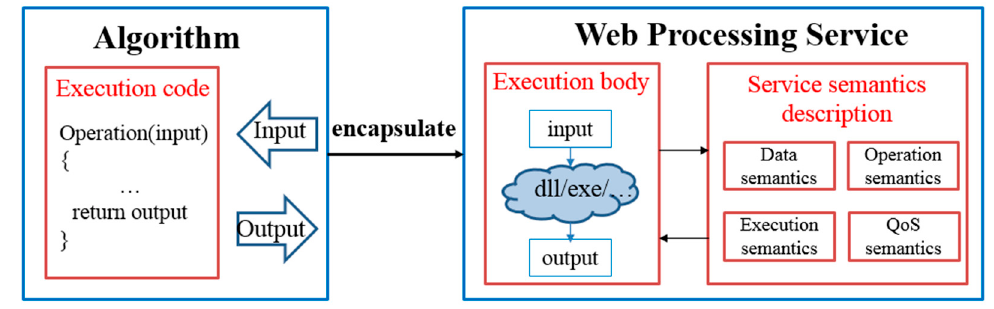
Figure 1. Process of encapsulating change detection algorithms into web processing services.